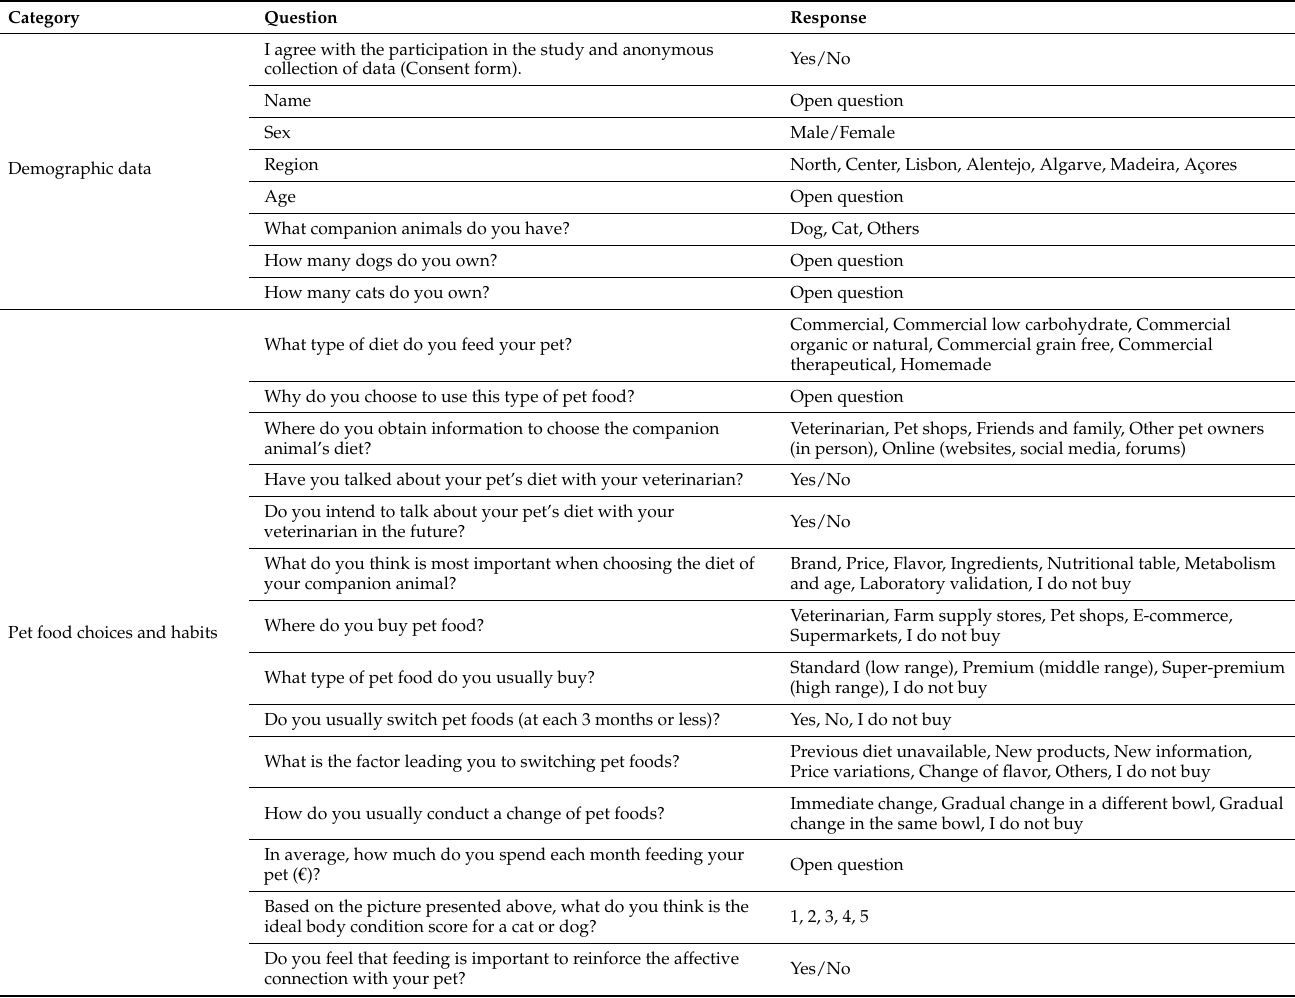
Table A1. Survey